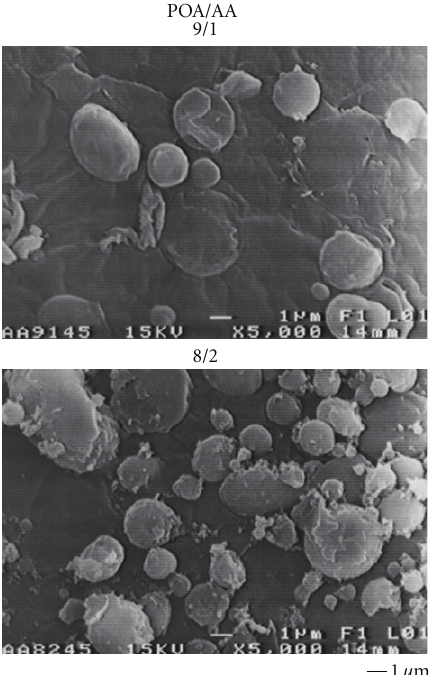
Figure 7: SEM images of the polymer particles obtained from the copolymers with 9/1 and 8/2 POA/AA ratios at 45 ◦ C and the cloud point pressure − 1500 psi.